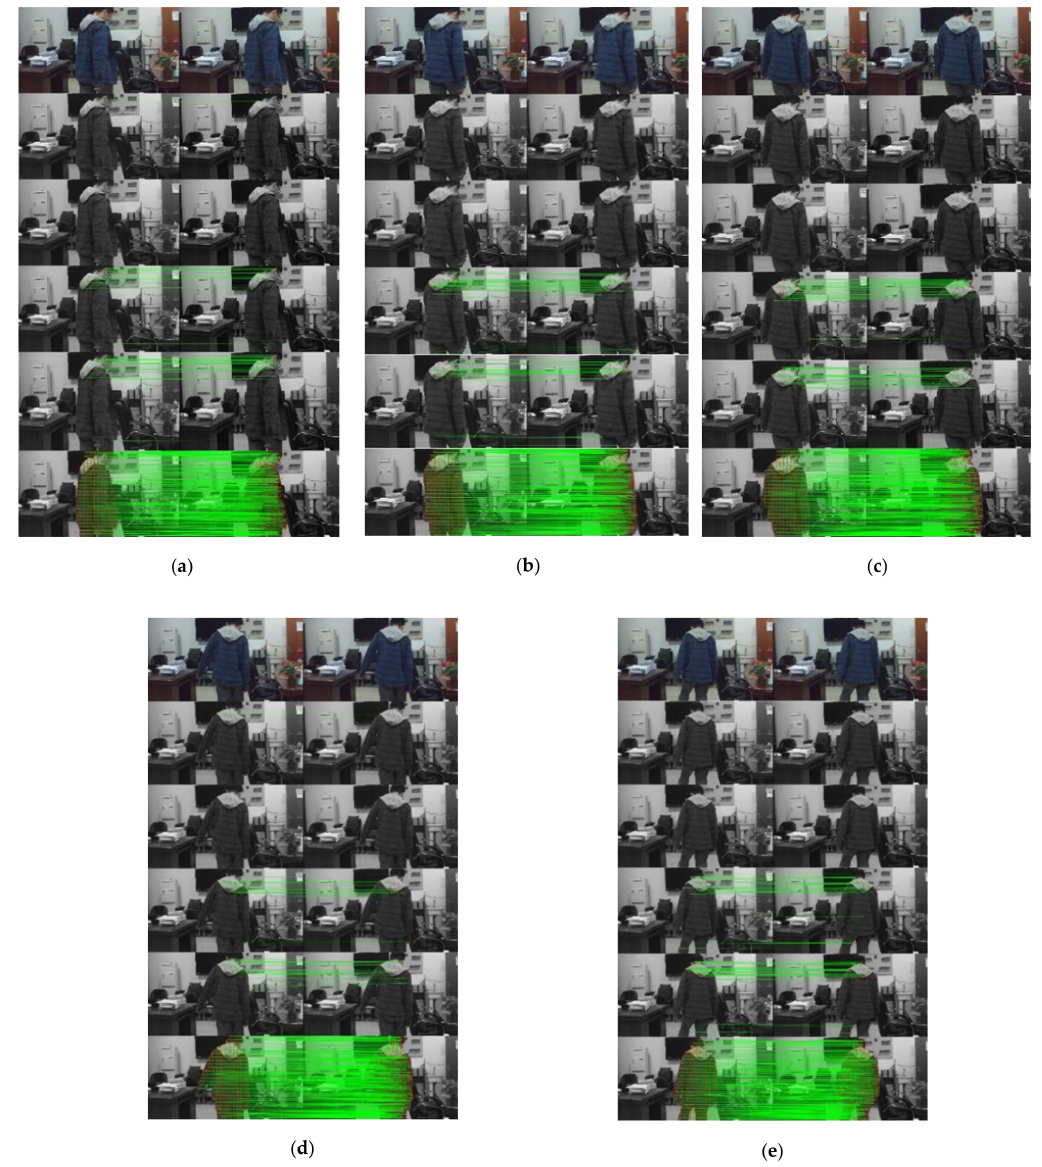
Figure 10. Matching results of the stereo point pairs in the moving target area of the 80~84 frames. From top to bottom are the corrected stereo image pairs of the 80~84 frames of ( a ) S-Fast, ( b ) S-Harris, ( c ) S-Sift, ( d ) S-Surf and ( e ) our target matching